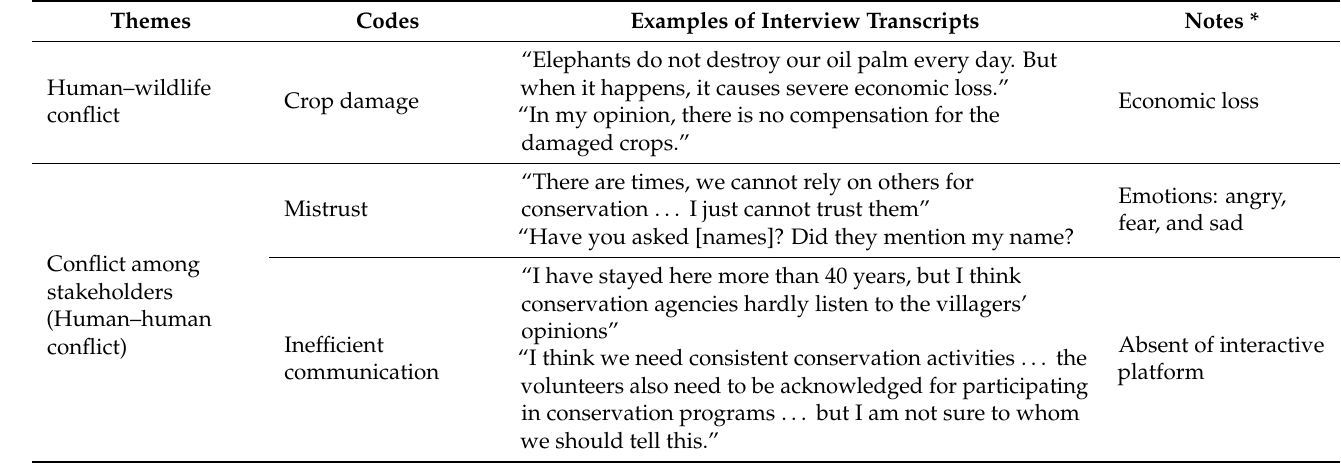
Table 2. Results of